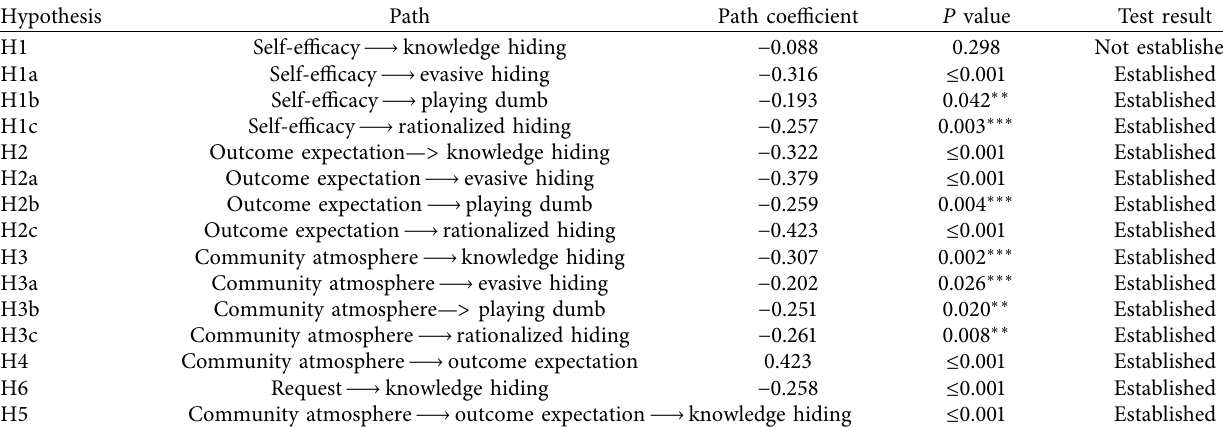
Table 11: Hypothesis test results.